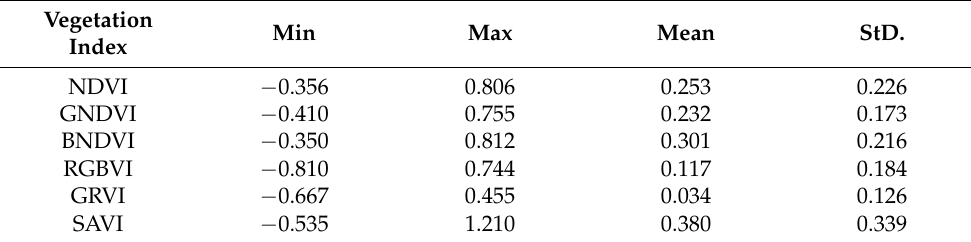
Table 4. Characteristics of existing vegetation index